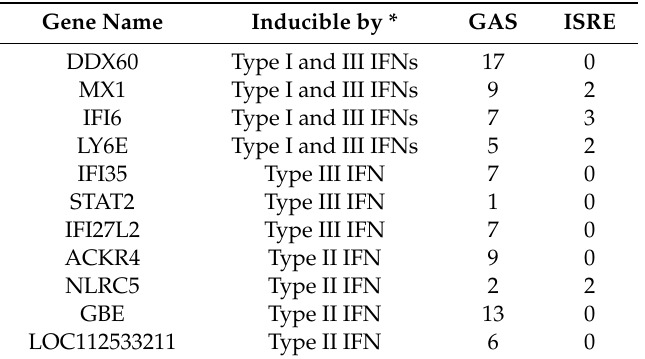
Table 1. Number of ISRE and / or GAS in selected